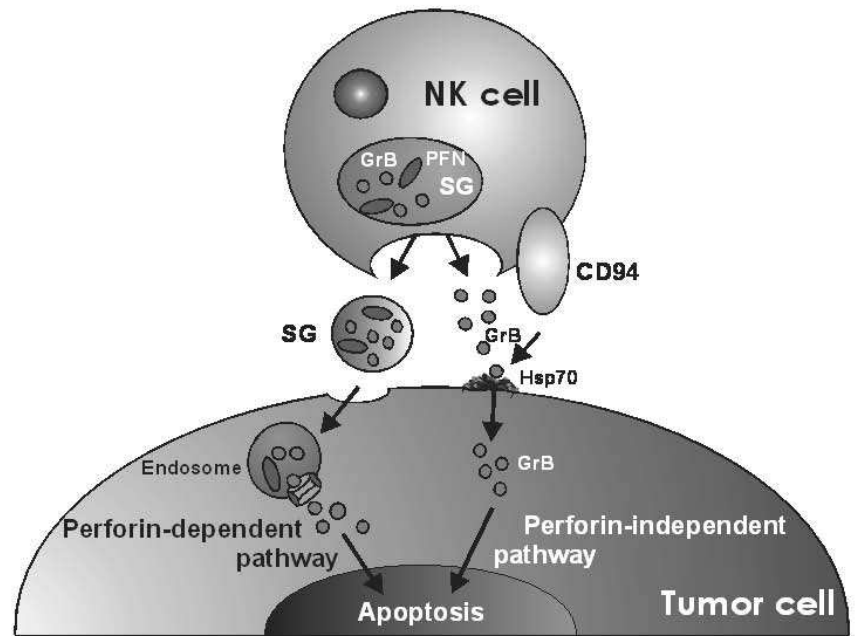
Fig. 3 Induction of apoptosis in Hsp70 membrane-positive tumor cells.